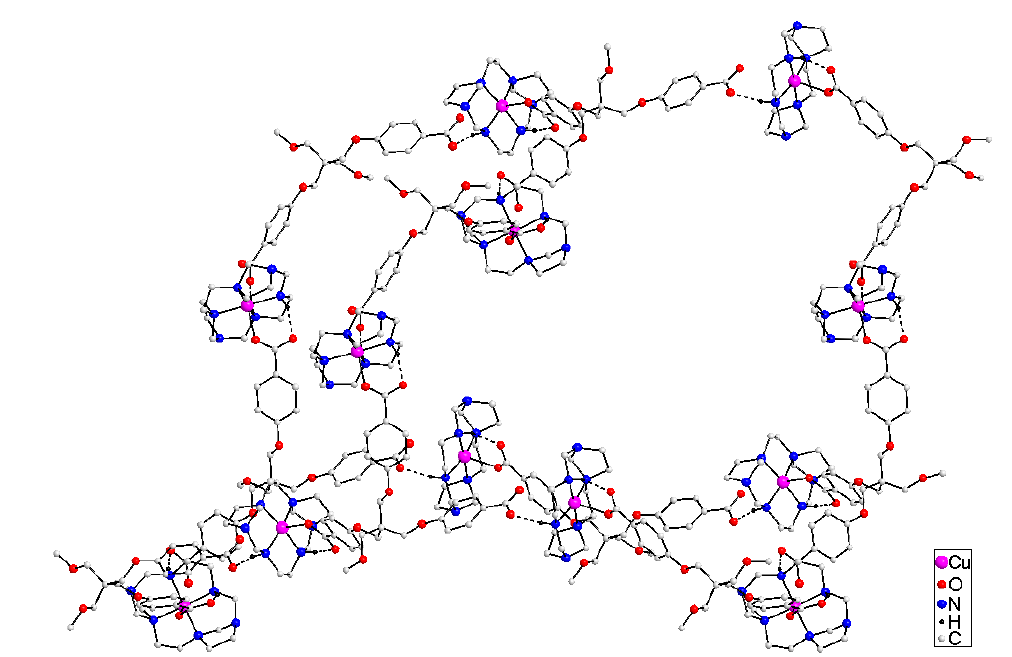
Figure 6. View of the highly distorted adamantantoid cage in the crystal of 3 •11H